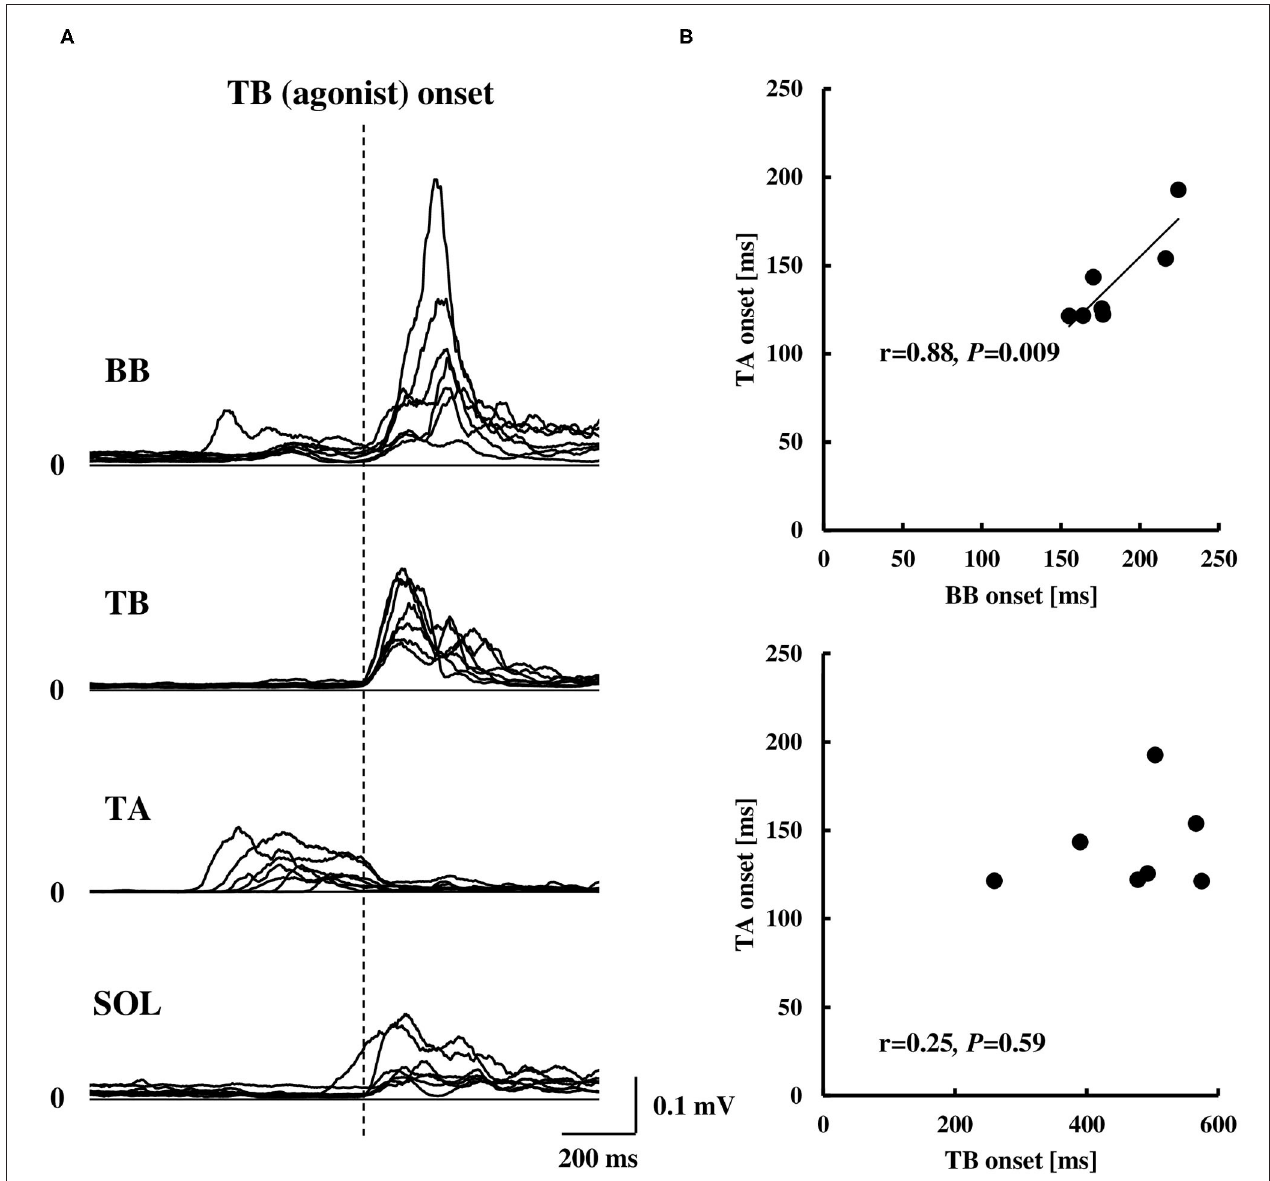
FIGURE 4 | Rectified EMG activities of the BB, TB, TA, and SOL muscles aligned to the EMG onset of the TB muscle ( A , n = 7) and correlation of the EMG onset of the TA muscle compared to the BB or TB muscle ( B , n = 7). Note that the EMG onset in (B) was calculated by the duration from visual cue to the EMG onset of each muscle. BB, biceps brachii; TB, triceps brachii; TA, tibialis anterior; SOL,